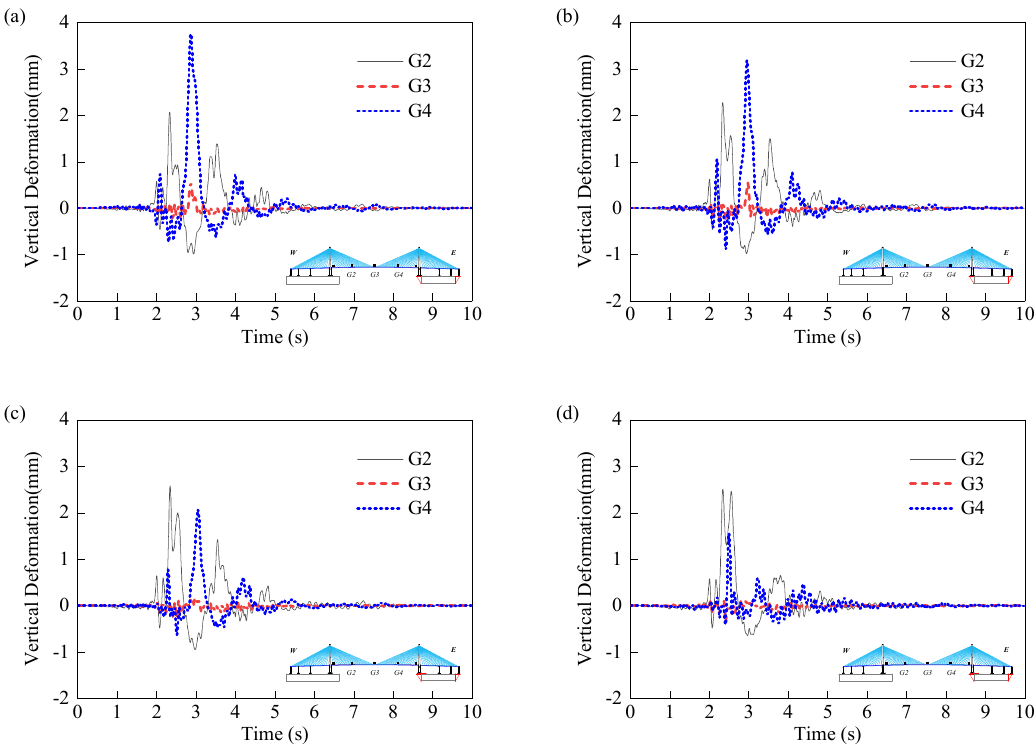
Figure 28. The girder vertical deformation time history subjected to ScTCU with ( a ) uniform; ( b ) dt = 0.1 s; ( c ) dt = 0.2 s; ( d ) dt = 0.4 s.